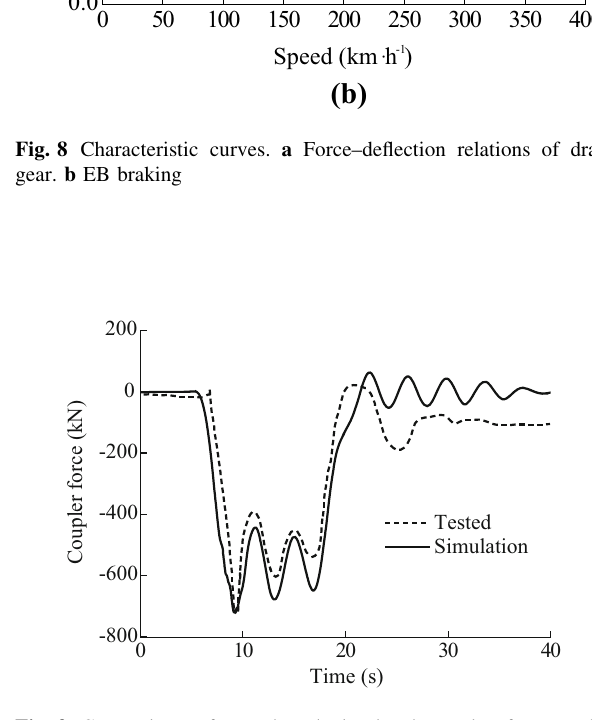
Fig. 9 Comparison of tested and simulated coupler force under CRH2E–CRH1B train to train rescue